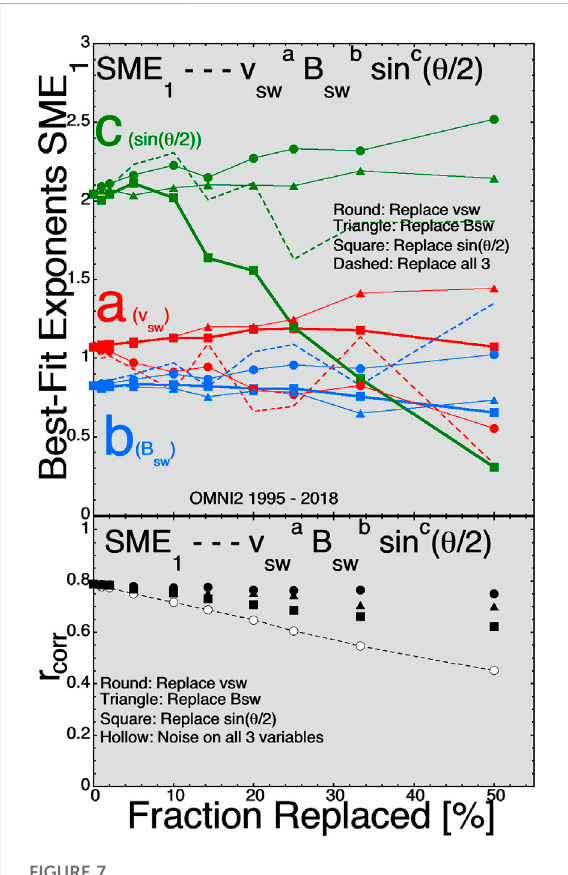
FIGURE 7 For best fi ts to the 1-hr-lagged SME 1 index the three exponents (A) (red), (B) (blue), and (C) (green)are plotted in thetop panelasfunctionsofthefractionoftime-seriesvaluesreplacedfor three solar-wind variables. In the bottom panel the Pearson linear correlation coef fi cient between D and SME 1 is plotted as a function of the fraction